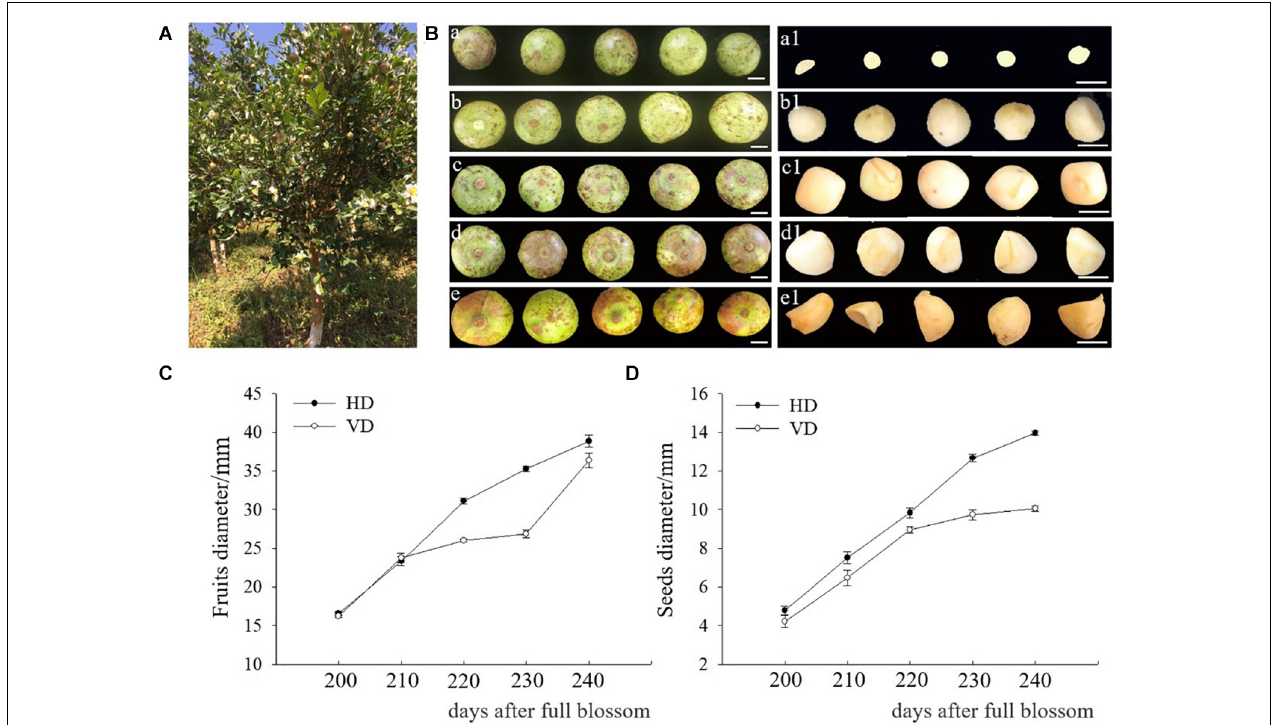
FIGURE 1 | Sampling at different developmental stages of C. oleifera . (A) Mature tea-oil tree. (B) The morphology of fruits and seeds from different developmental stages. (a, a1) Fruits and seeds 200 days after full blossom. (b, b1) Fruits and seeds 210 days after full blossom. (c, c1) Fruits and seeds 220 days after full blossom. (d, d1) Fruits and seeds 230 days after full blossom. (e, e1) Fruits and seeds 240 days after full blossom. (C) Horizontal and vertical diameters (HD, VD) of fruits after full blossom. (D) Horizontal and vertical diameters of seeds after full blossom. Bars: (a, a1) = 6 mm, (b, b1) = 8 mm, (c, c1) = 10 mm, (d, d1) = 12 mm, and (e, e1) = 13